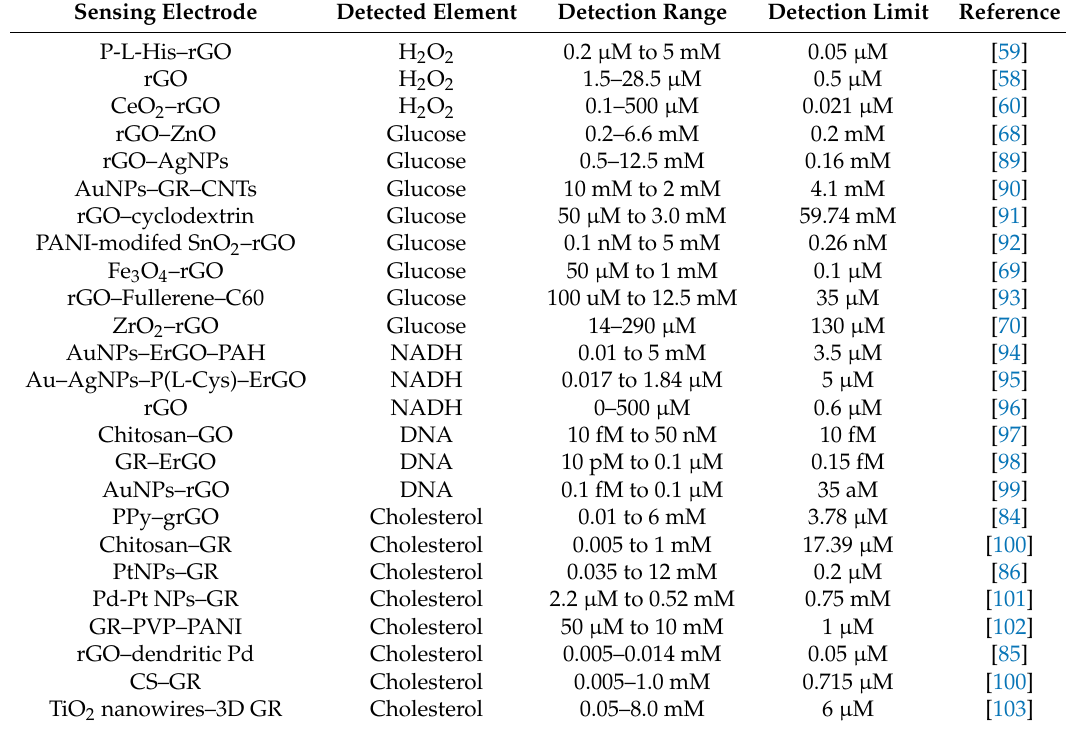
Table 1. Performance of enzymatic biosensors based on graphene based nanomaterials for the detection of clinically important